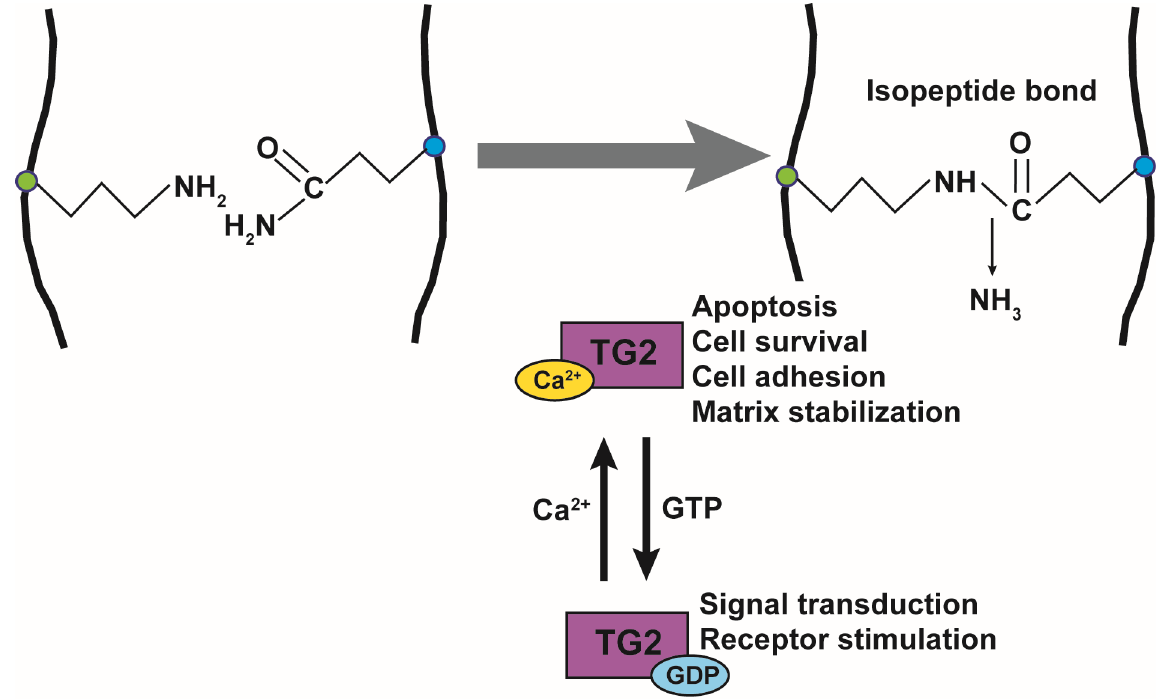
Figure 1. Transglutaminase 2 activity and function. Transamidation activity of transglutaminase 2 (TG2) is activated by Ca 2+ and catalyzes the formation of an isopeptide bond. TG2 function is also regulated by guanosine triphosphate (GTP) binding. Ca2+-binding to TG2 regulates apoptosis, cell survival, cell adhesion, and matrix stabilization, while the binding of GDP to TG2 regulates signal transduction and receptor activation.